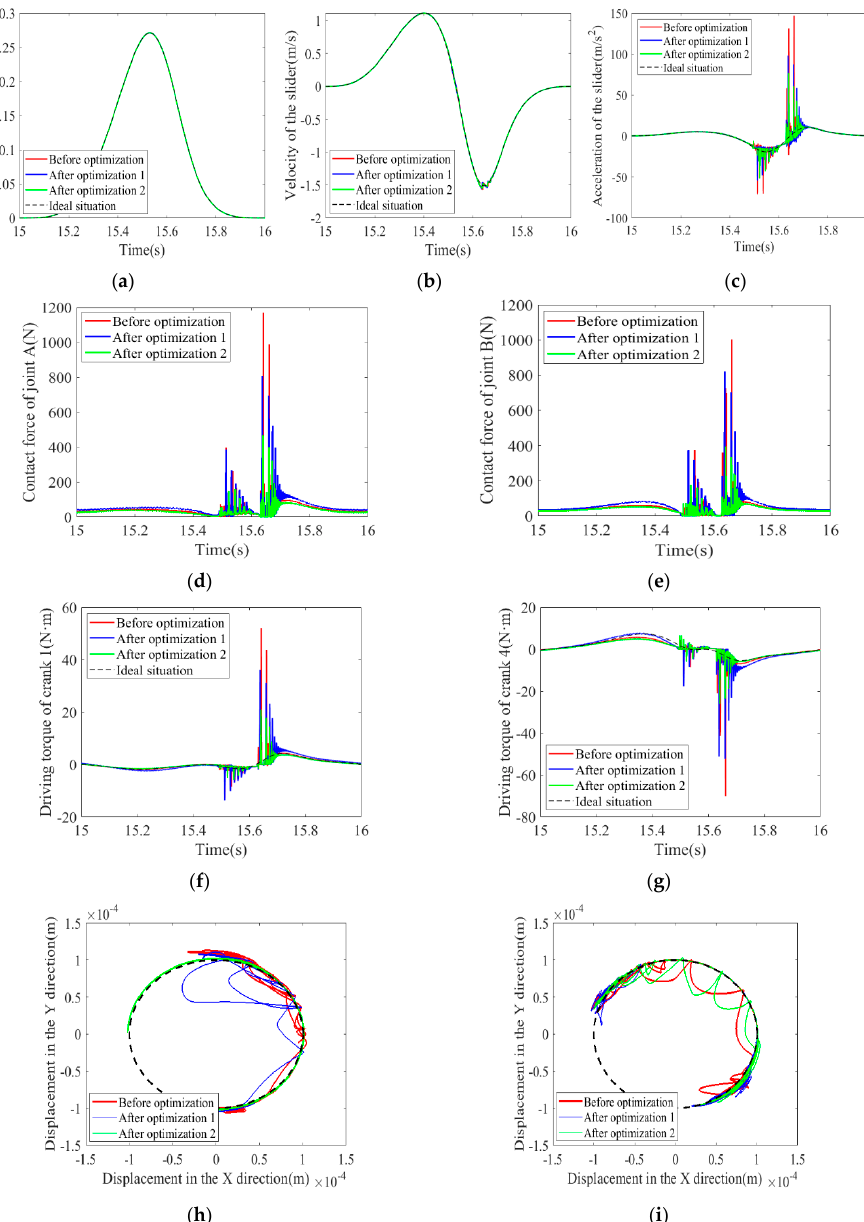
Figure 6. Dynamics response. ( a ) Displacement of the slider. ( b ) Velocity of the slider. ( c ) Acceleration of the slider. ( d ) Contact force of joint A. ( e ) Contact force of joint B. ( f ) Driving torque of crank 1. ( g ) Driving torque of crank 4. ( h ) Central trajectory of clearance A. ( i ) Central trajectory of clearance